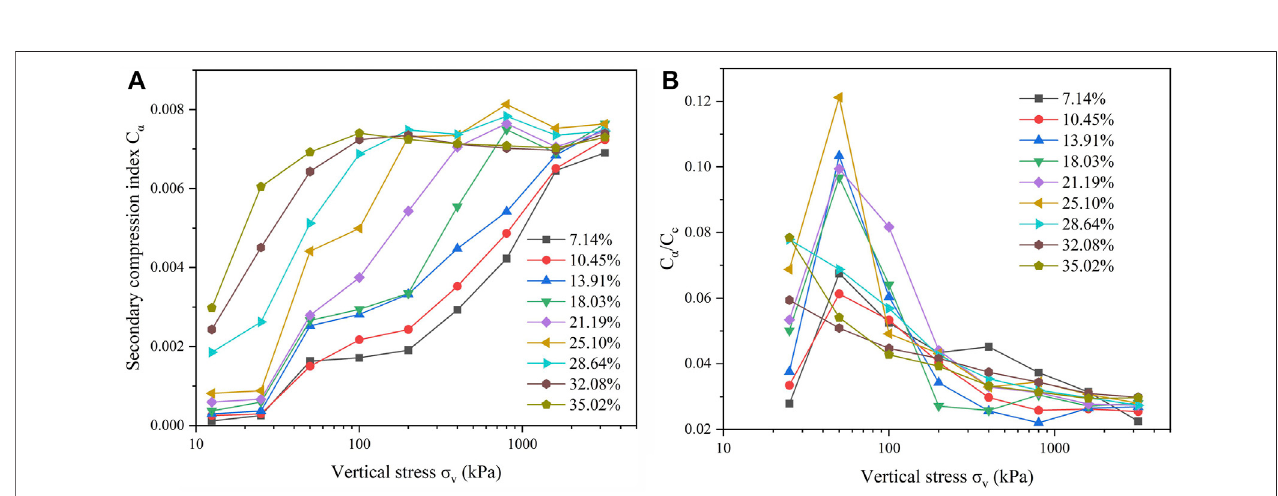
FIGURE 9 | Variation of secondary compression index C c and C α /C c with vertical stress for intact loess at different water contents: (A) C α , (B) C α /C c .